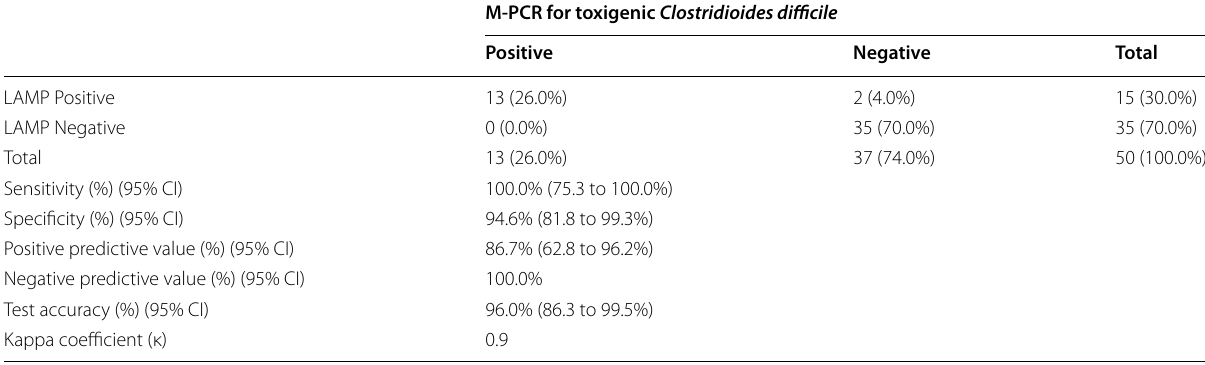
Table 5 Comparison of the loop mediated isothermal amplification (LAMP) with the multiplex polymerase chain reaction (M-PCR) in the detection of the toxigenic Clostridioides